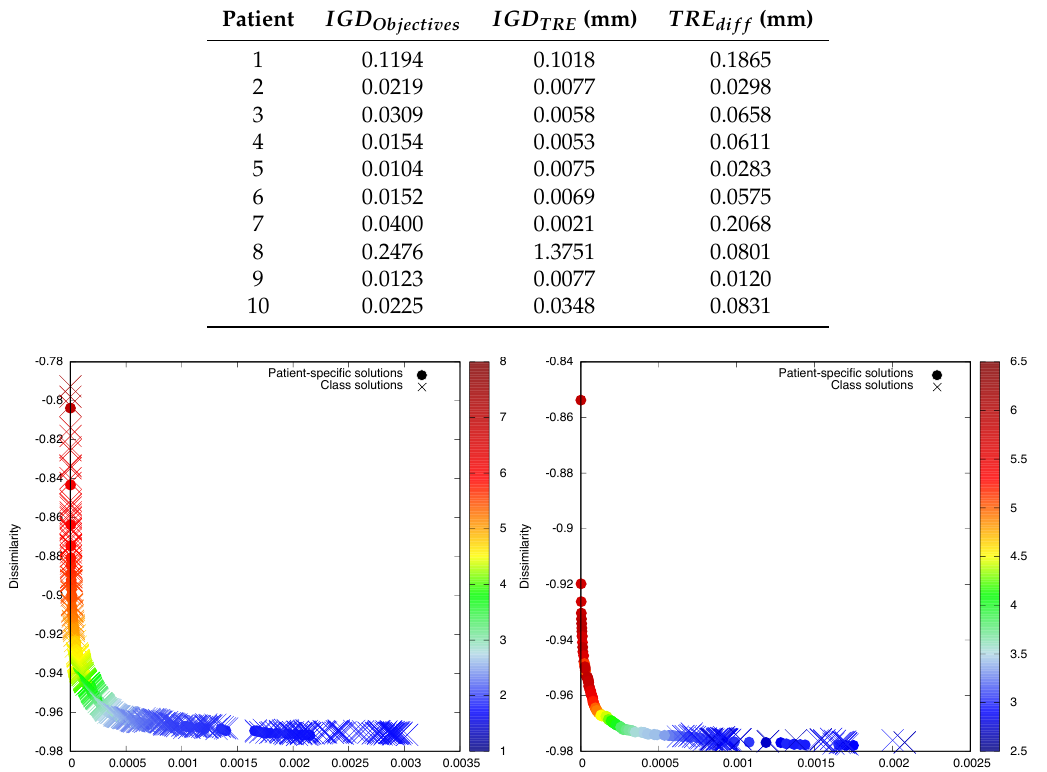
Figure 5. Non-dominated front of patient-specific solutions and class solutions for Test Cases 6 ( left ) and 8 ( right ), colour coded with the mean TRE in mm. The colour scales are different for each case, to illustrate the different TRE distributions